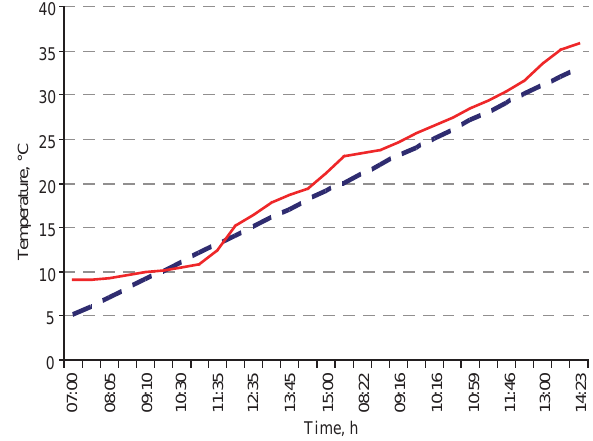
Fig. 2. Comparison of temperature values measured by the electronic thermometer TE-100 and the temperature sensors in asphalt pavement layer: temperature measured by thermometer TE-100 in 10 cm depth of asphalt layer; temperature measured by sensor of temperature in 10 cm depth of asphalt